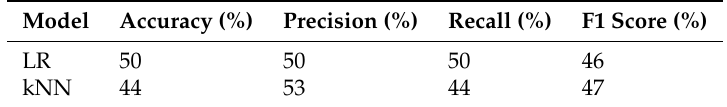
Table 6. Metric scores obtained by using the models fitted to in vivo raw dielectric property data on testing of the literature